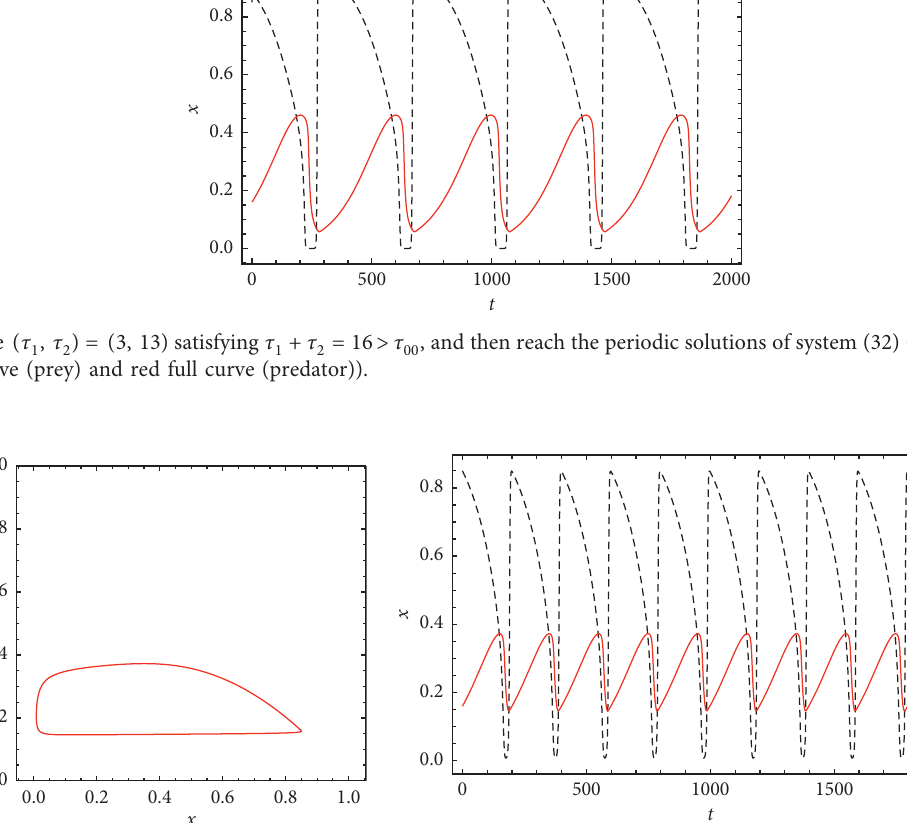
Figure 8: Numerical simulation of system (51). (a) The orbit is shown in red in the phase space. (b) Time series with the black dashed curve (prey) and red full curve (predator).